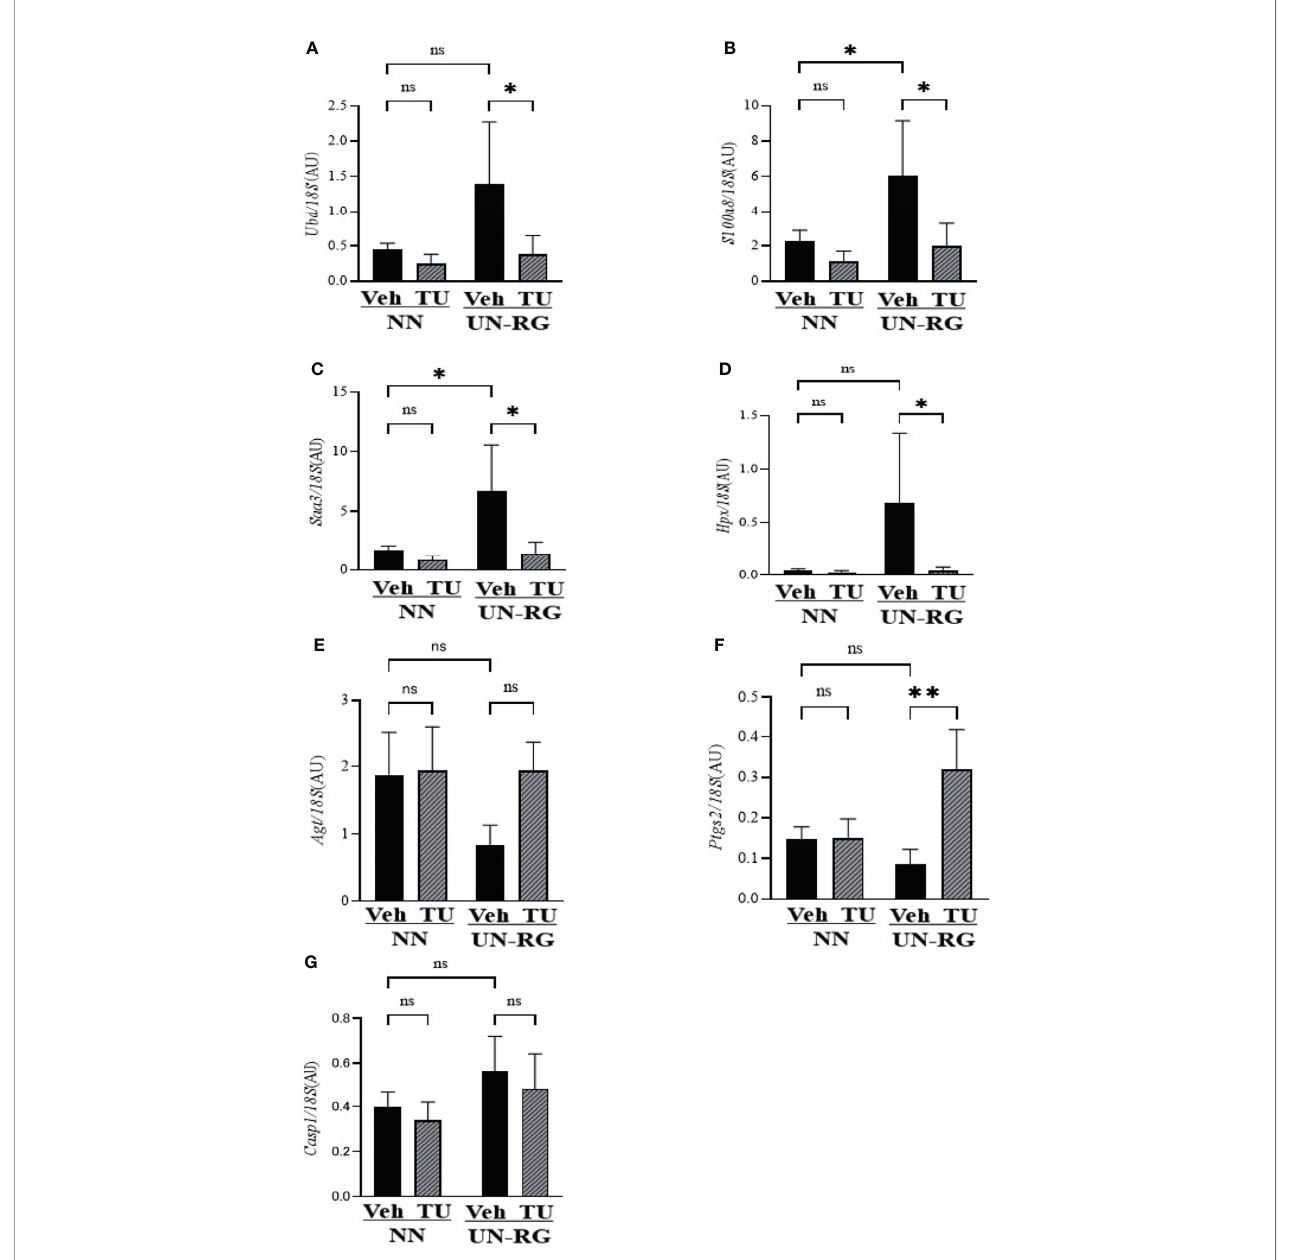
FIGURE 7 | Quantitative RT-PCR analysis of the mRNA expression of seven GOI ( Table 3 ) in epididymal adipose tissues of NN-Veh, NN-TU, UN-RG-Veh, and UN- RG-TN pups at 16.5 wks. *P < 0.05; **P < 0.01. ns, no statistically signi fi